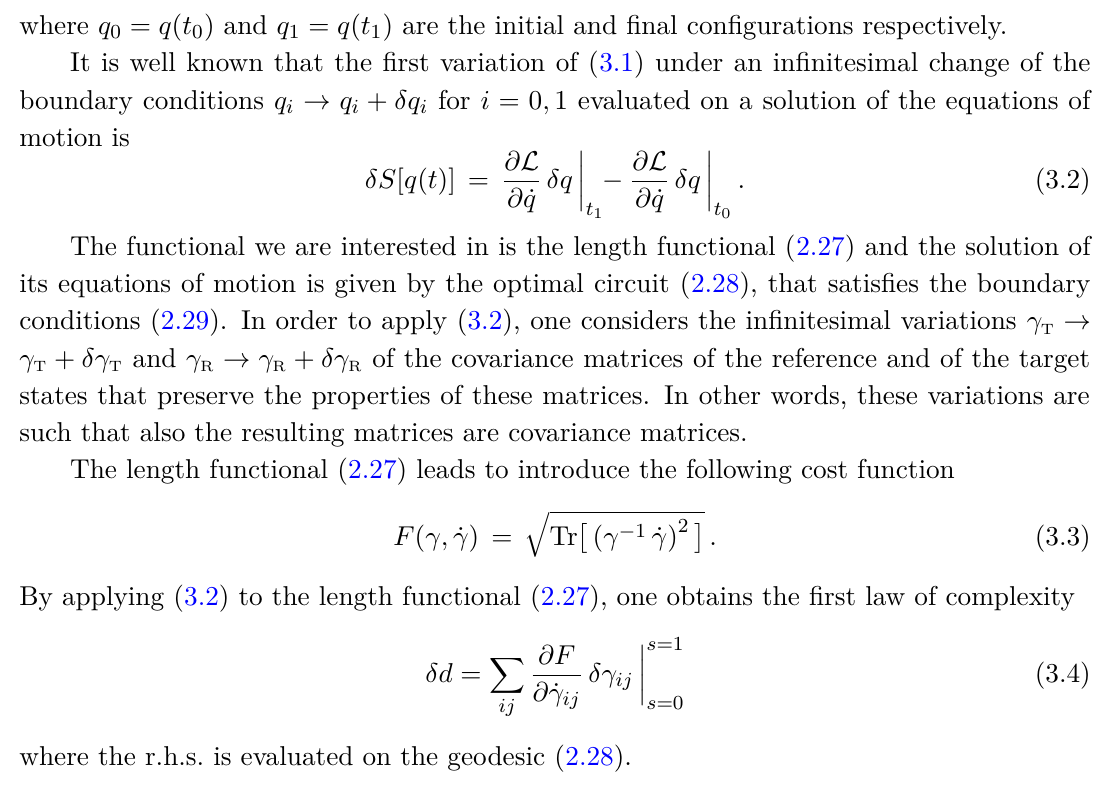
Figure 2 . The solid black curve and the solid coloured curves have been defined in figure 1. Eq. (3.18) tells us that the dashed black curves represent the W through γ and γ respectively (the auxiliary covariance matrices ˜ γ R T in (5.1)). The arcs of the dashed curves that connect the blue curve to the red curve have the same length given by